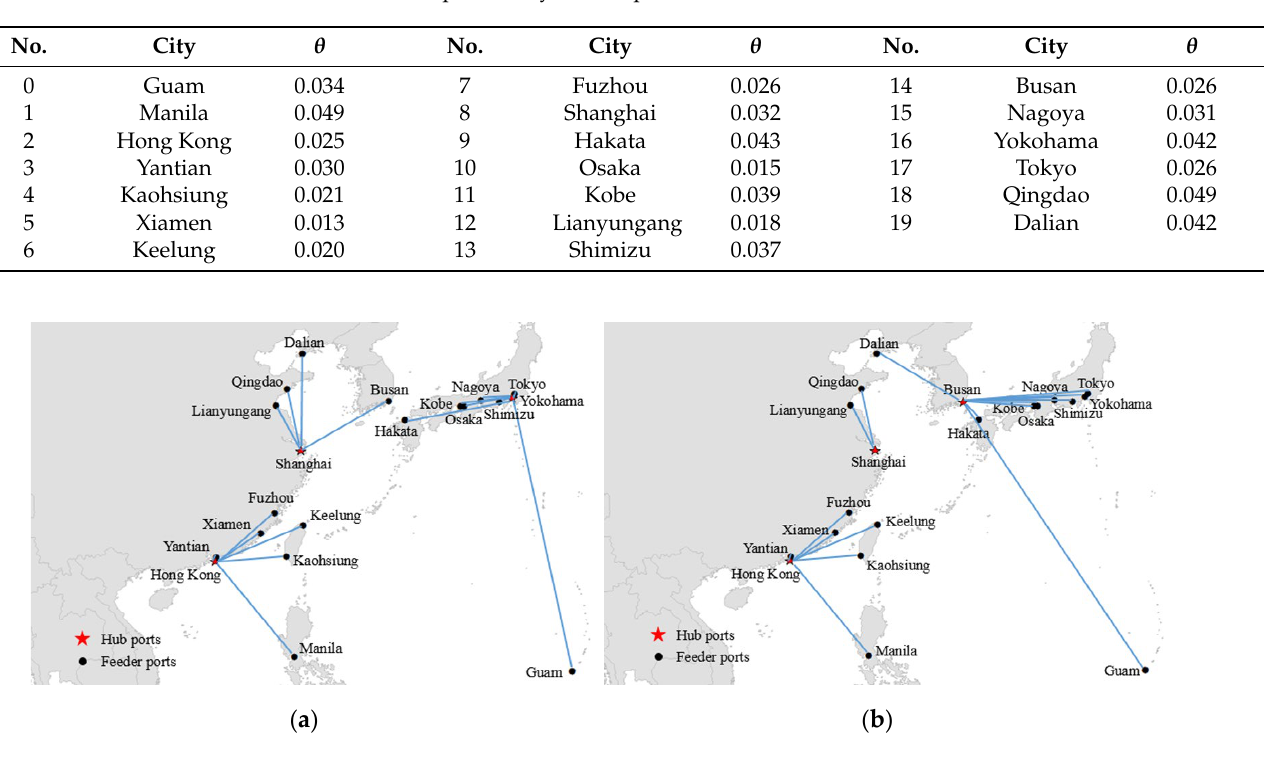
Figure 5. Hubbing probabilities for each port under multiple allocation schemes. ( a ) = p 2 , ( b ) = p 3 .